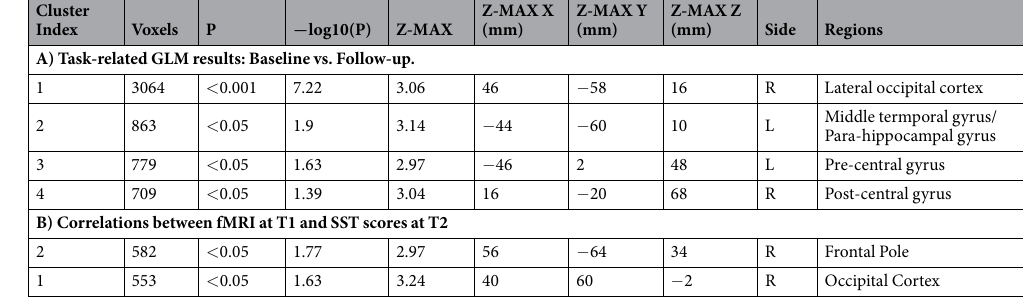
Table 1. (A) shows the coordinates for the task-related GLM results. (B) shows the correlations between fMRI at T1 and SST scores at T2.